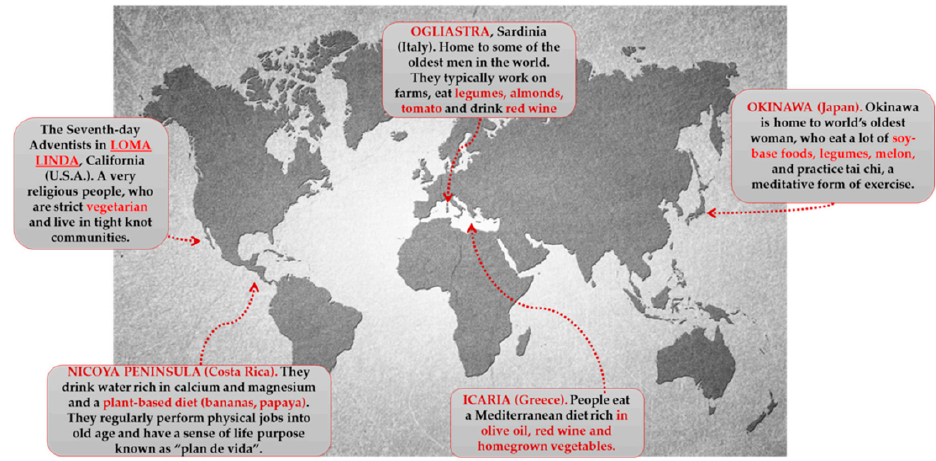
Figure 3. Blue zones of the